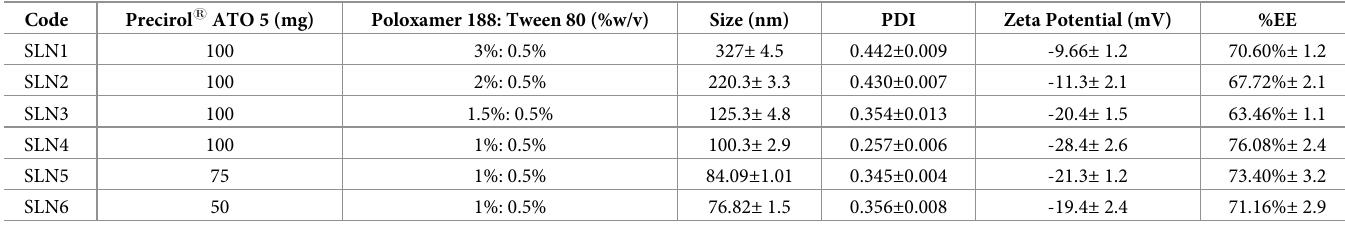
Table 1. Physicochemical characteristics of 5-FU-loaded